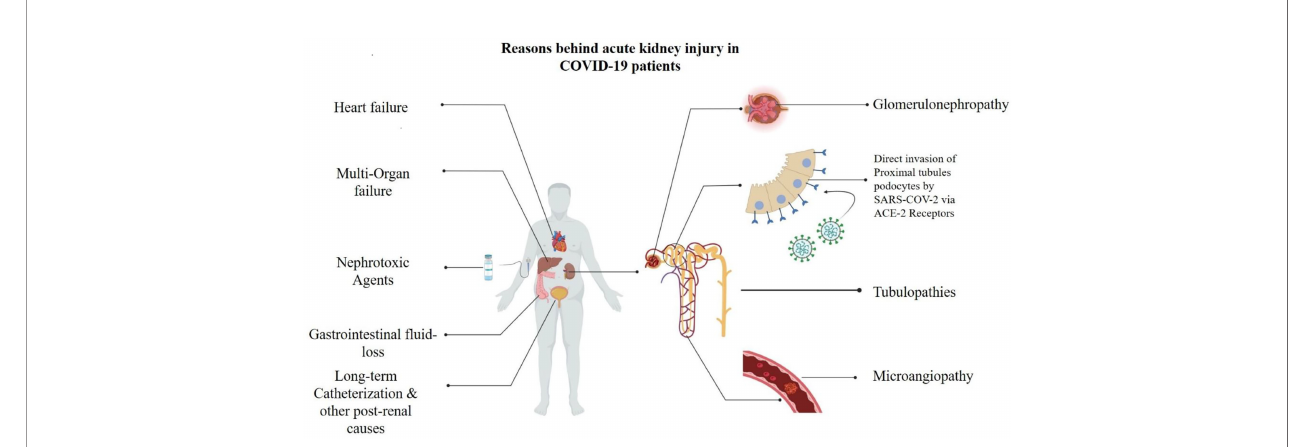
FIGURE 5 | Underlying mechanims contributing to onset of acute kidney injuries (AKI) in